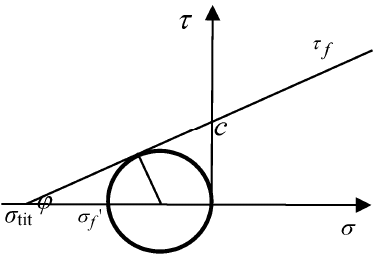
Figure 14. Failure Mohr stress circle.